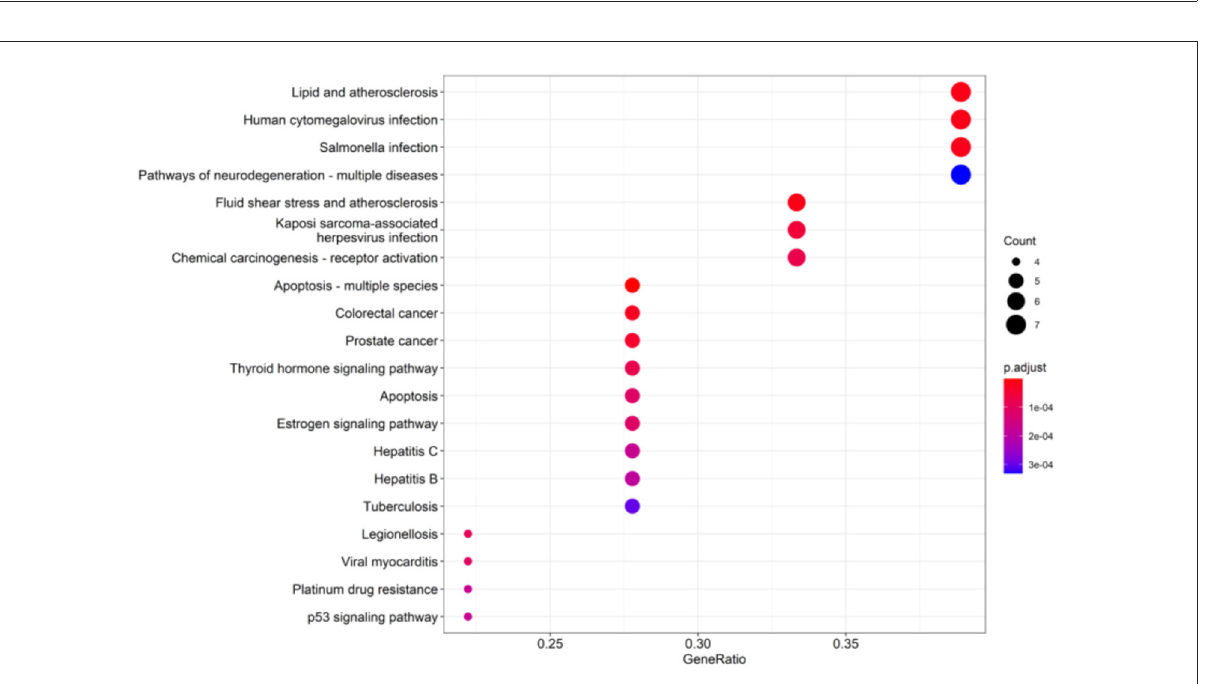
acted on the thyroid hormone signaling pathway, estrogen signaling pathway, p53 signaling pathway, etc. In this study, potential bioactive compounds and antioxidant mechanisms against oxidative and free radical damage in mung bean were preliminarily elucidated, to provide a reference for the